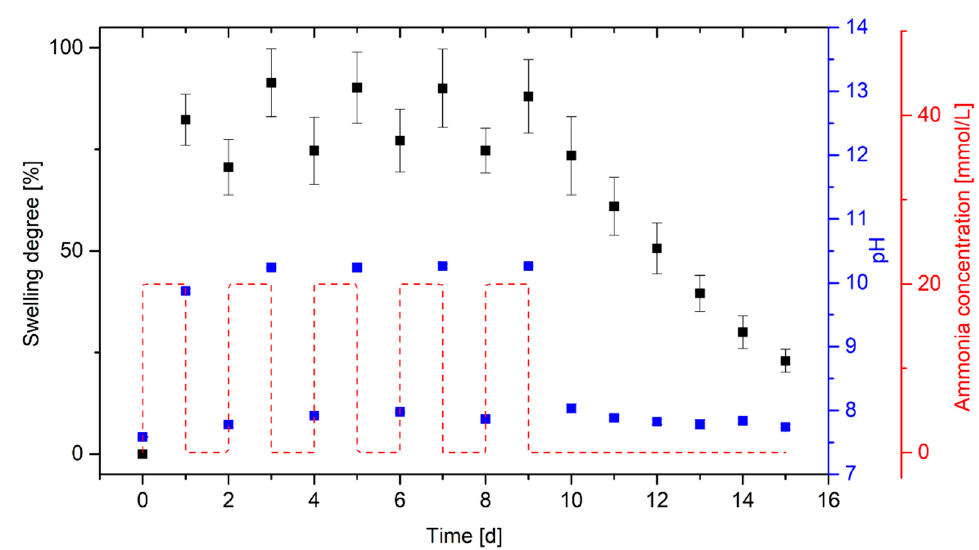
Figure 5. Repeated swelling of poly(AAc- co -DMAEMA) (60 mol% AAc, 40 mol% DMAEMA) hydrogels at two alternating ammonia concentrations (20 mmol/L and 0 mmol/L) in PBS buffer and resulting pH value of the solutions.